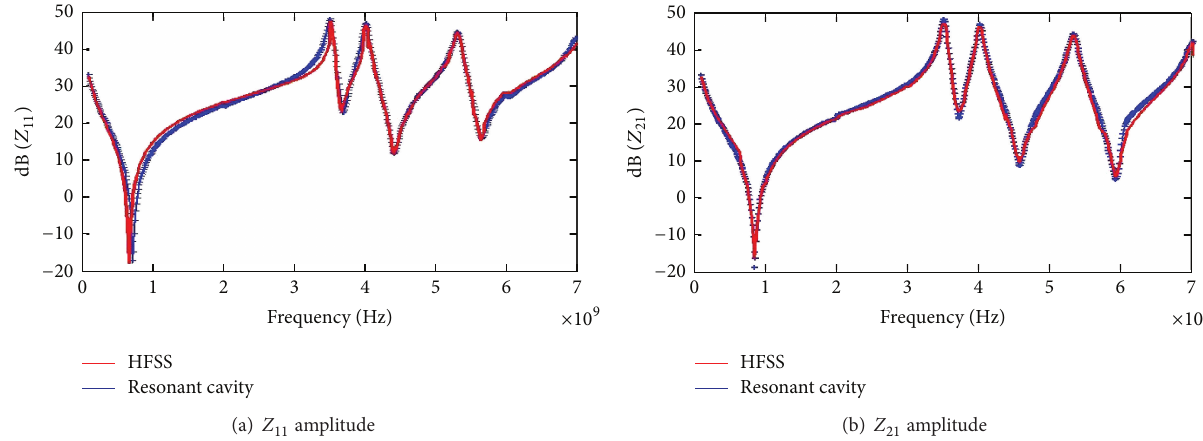
Figure 3: The curves of impedance parameters of integrated rectangular plate based on resonant cavity method.